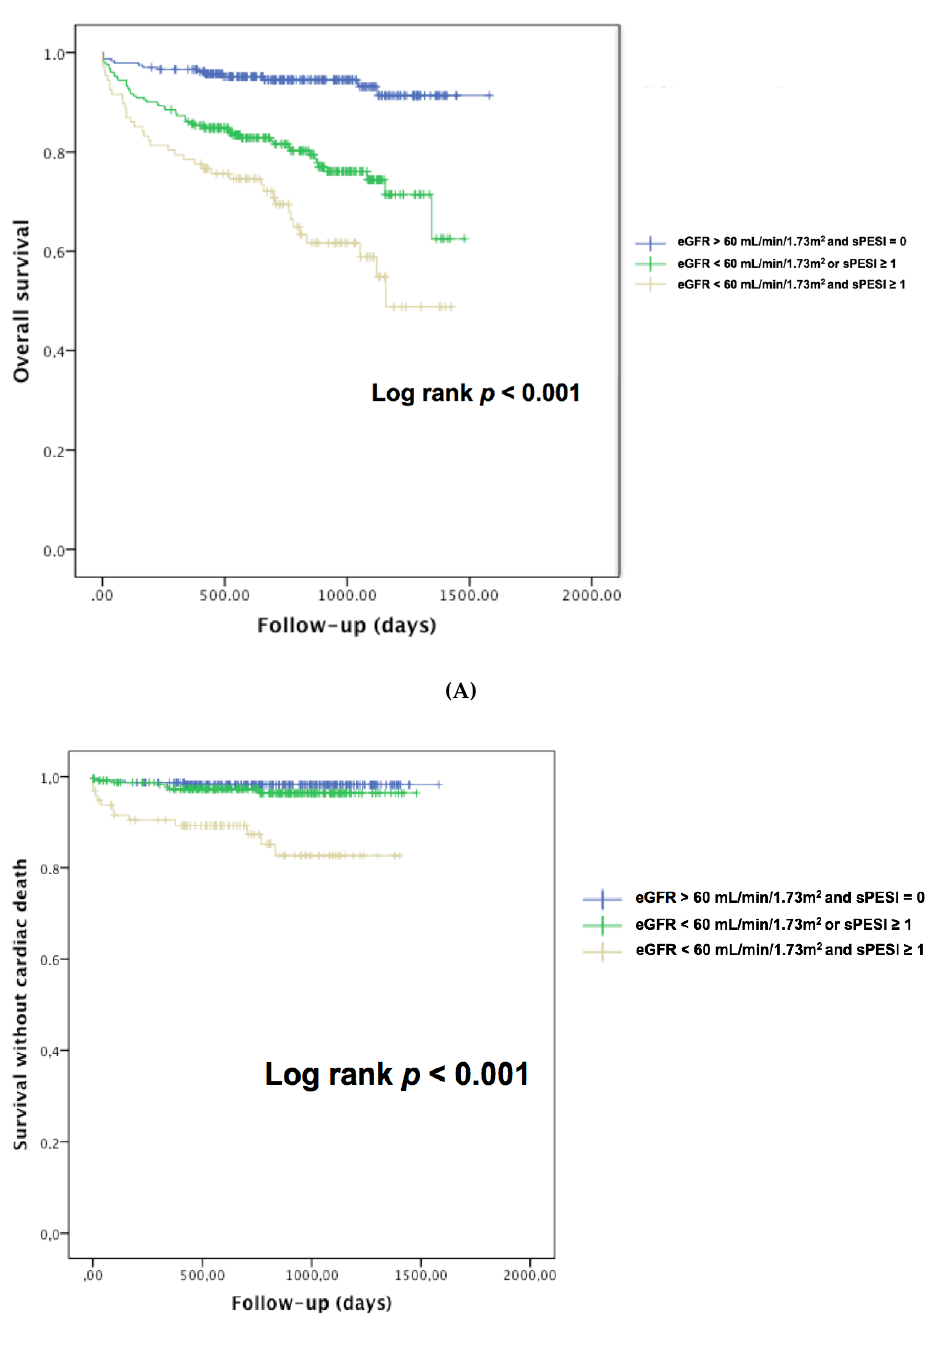
Figure 3. ( A ) Kaplan–Meier analysis for the probability of overall survival according to sPESI and renal dysfunction in patients with acute pulmonary embolism. ( B ) Kaplan–Meier analysis for the probability of cardiac survival according to sPESI and renal dysfunction in patients with acute pulmonary embolism.